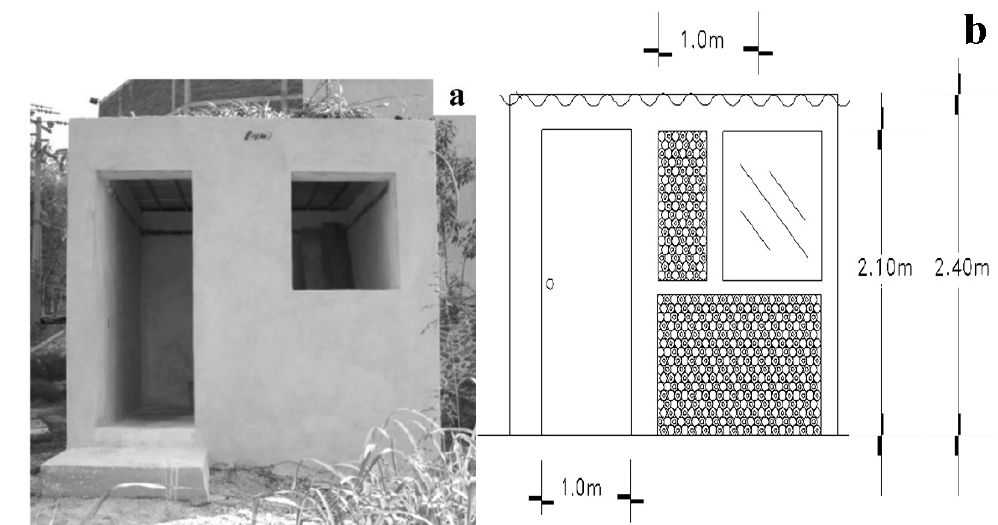
Figure 7. The front view of the prototype: ( a ) Picture taken before installing the door and window; ( b ) the initial design concept of the façade.